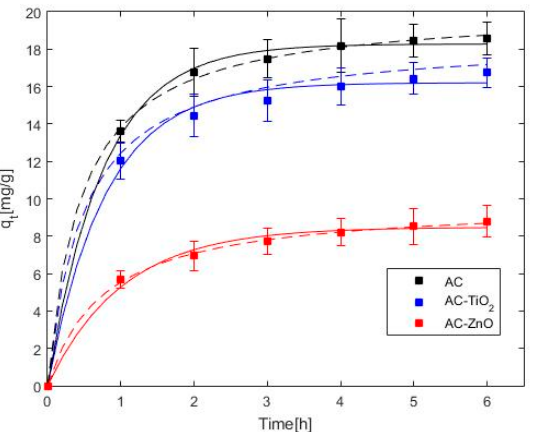
Figure 8. Adsorption kinetics of phenol. Dashed line (- -) is pseudo-first order (PFO) and solid line (-) is pseudo-second order (PSO) model. Table 3. Kinetic parameters of the model PFO and PSO.